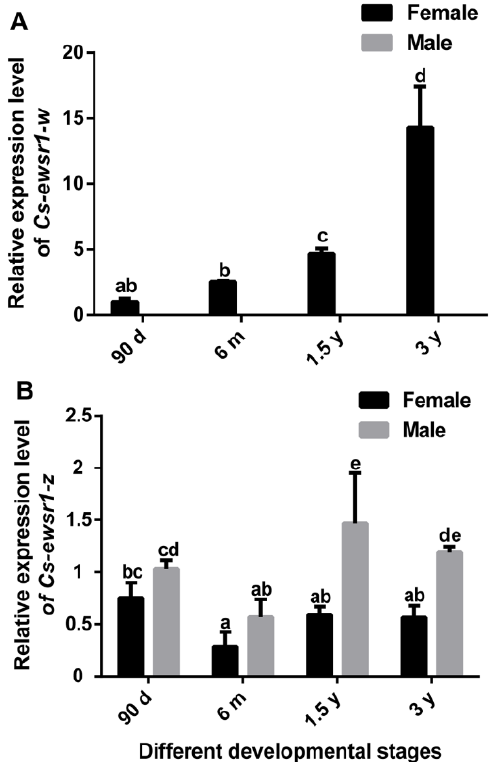
Figure 4. The relative expression patterns of Cs-ewsr1-w ( A ) and Cs-ewsr1-z ( B ) genes in female and male gonads from different developmental stages. Different letters represent significant differences among species ( p < 0.05).